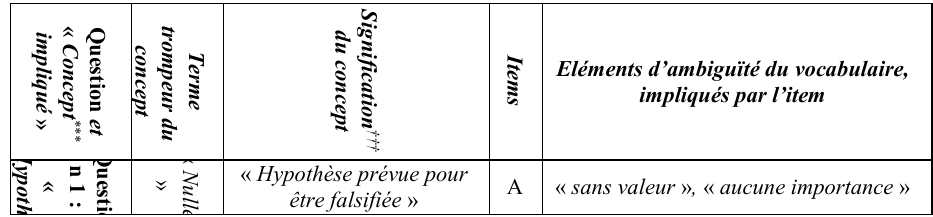
Tableau 1. Récapitulatif des éléments caractéristiques des différents